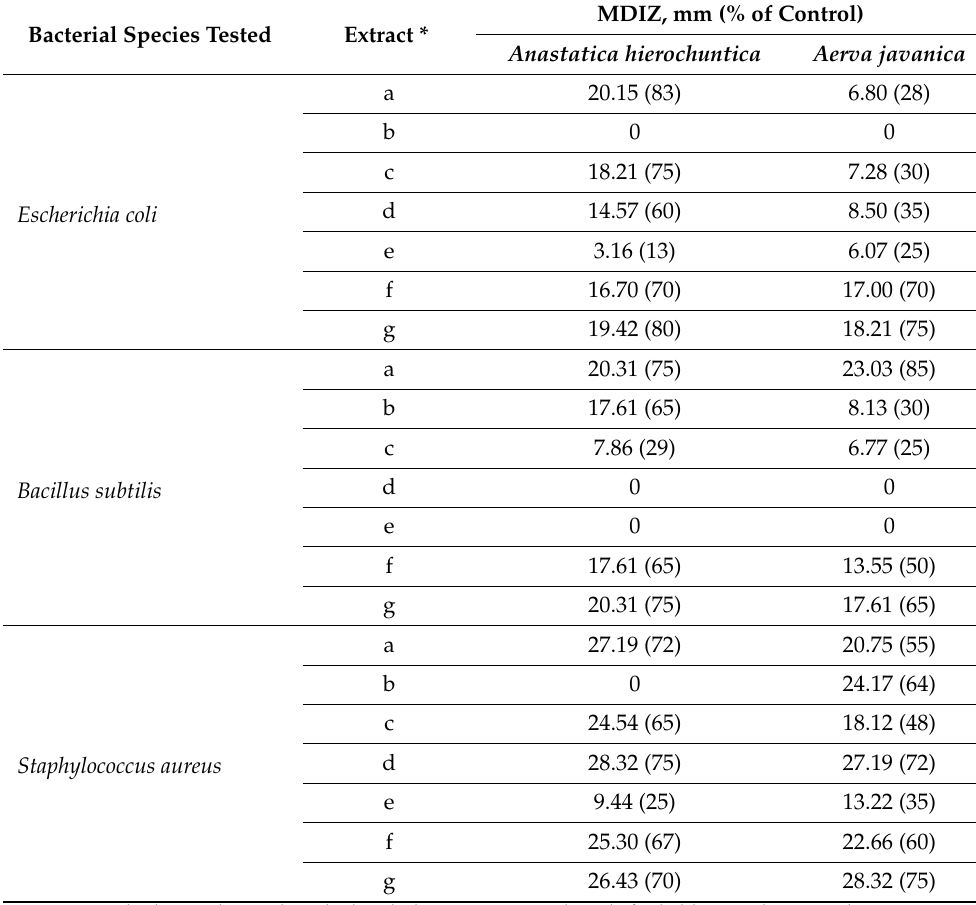
Table 2. Antibacterial activity of Anastatica hierochuntica and Aerva javanica extracts grown in